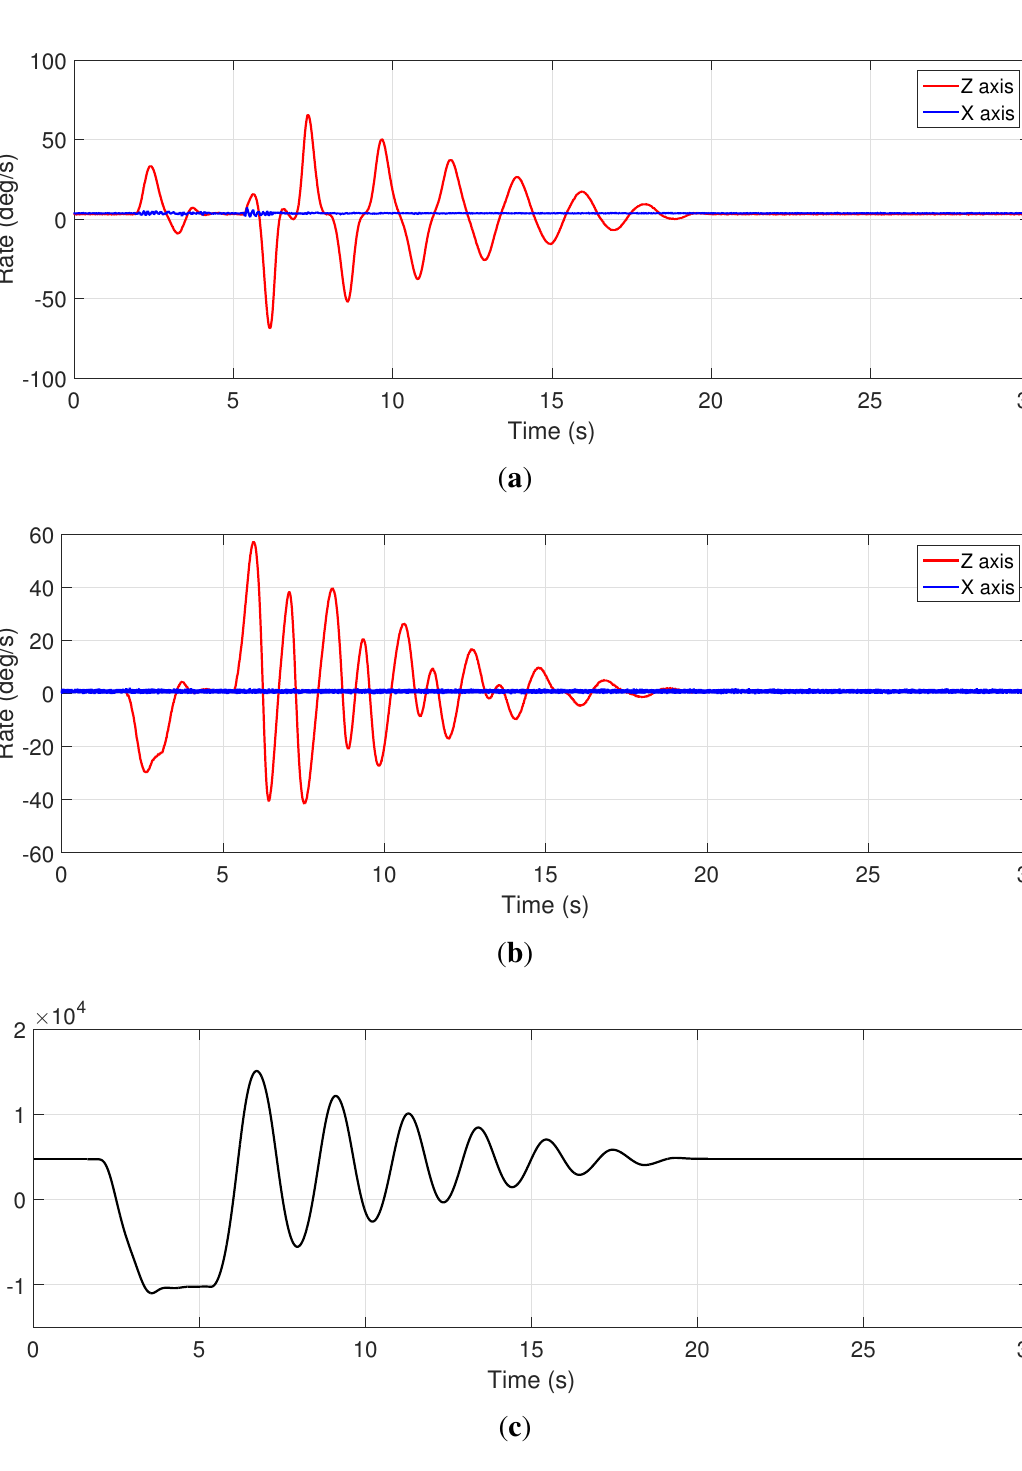
Figure 7. Measurements for the mechanism tested with the proposed DAQ system. Gyroscope readings for the connecting and rocker rods are shown in ( a , b ), respectively; Since the mechanism is planar, gyroscopes aligned with the Z axis provide the most significant measurements; Incremental encoder data is shown in ( c ), in pulse units (the encoder generates 40 × 10 3 pulses per